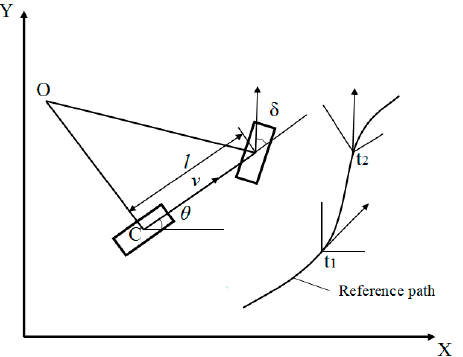
Figure 15. Schematic diagram of the kinematic model.